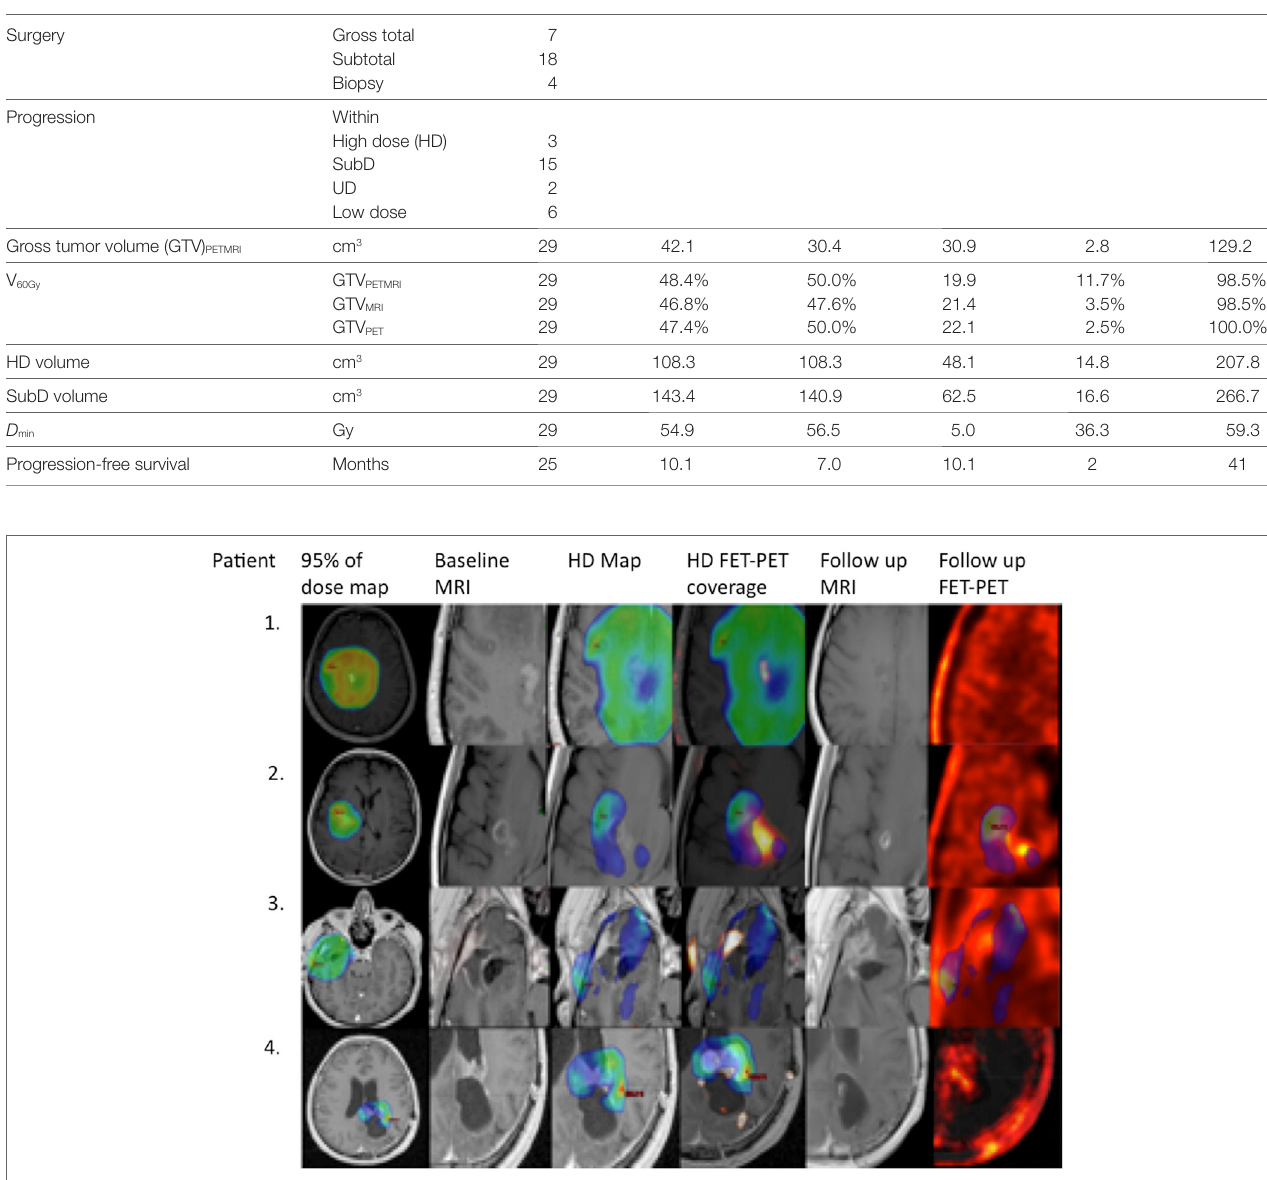
FigUre 3 | Primary fluoroethylthyrosine-PET (FET-PET) revealed an active area that was not irradiated with high dose (HD), representing a progression starting point. Areas irradiated with HD responded to treatment. From the left: primary MRI with 95% dose map, primary MRI, primary MRI with HD map, primary FET-PET/ MRI with HD map, MRI at time of progression, and FET-PET at time of progression. Upper row: an example of a patient with high 100% V60 coverage of gross tumor volume (GTV) PET and no progression 41 months after treatment. The second example is a patient with a V60 of GTV PET of 83% and progression-free survival (PFS) of 32 months. The third example is a patient with a V60 of 45% and PFS of 7 months, and the bottom row is a patient with a V60 of 75% and PFS of 7 months.